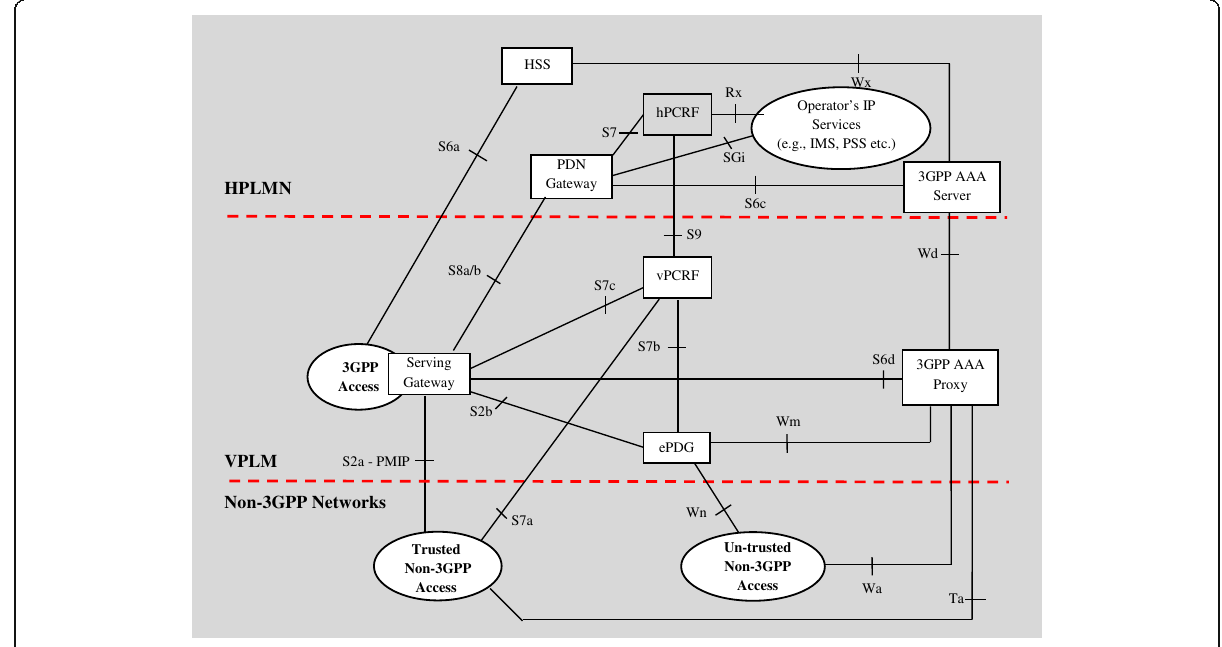
Fig. 1 E-UTRAN interworking with 3GPP and non-3GPP wireless networks